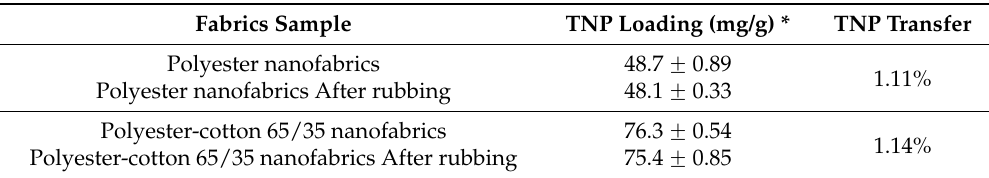
Table 2. TNP transfer after dry rubbing.